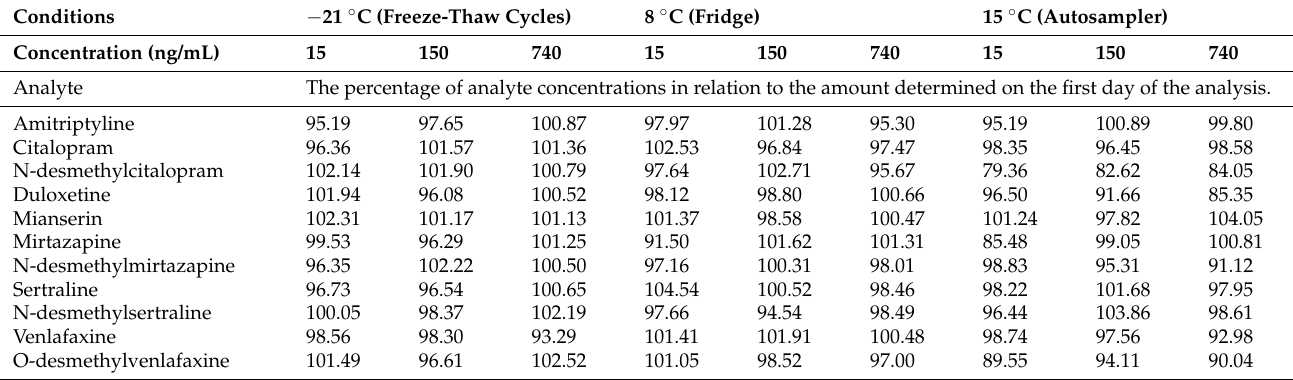
Table 3. Stability study of analytes in spiked